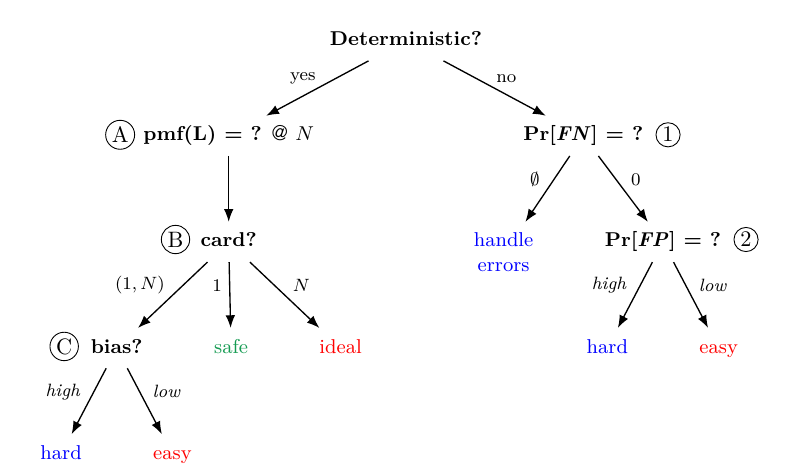
Figure 1: OTA evaluation flow (attacker